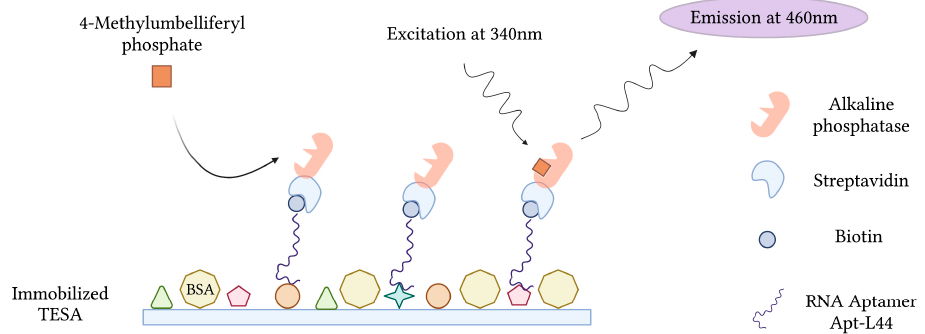
Figure 9. The schematic illustration of the Enzyme-Linked Aptamer (ELA) assay for the detection of T. cruzi excreted secreted antigens (TESA) described by Nagarkatti et al. [63]. Created with BioRender.com (accessed on 19 December 2021).